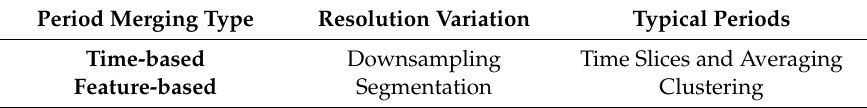
Table 3. Overview over frequently used methods and their possible combinations. Period Merging